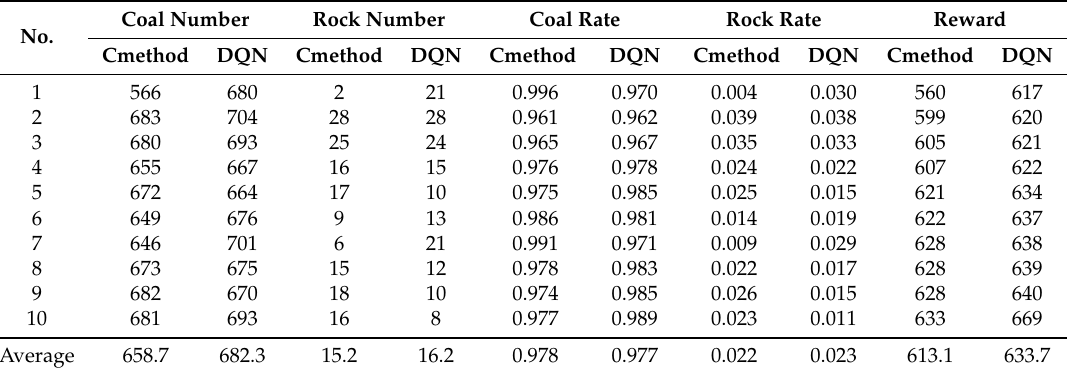
Table 4. Experiment